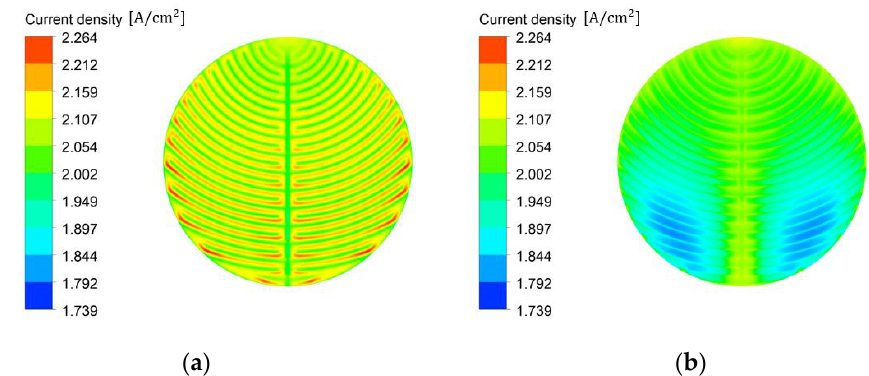
Figure 12. Current density distribution of PEMWE on the active area by channel width-to-rib width ratio ( a ) W Ch : 3 mm, W Rib : 1 mm, ( b ) W Ch : 1 mm, W Rib : 3 mm ( H Ch : 1 mm, ε : 0.75, K : 30.2 × 10 −12 m 2 , θ : 30°, 𝑄̇ 𝑖𝑛 : 10 sccm, T in : 328.15 K, T cell : 328.15 K, V op : 1.8 V and 𝑔 : z+).